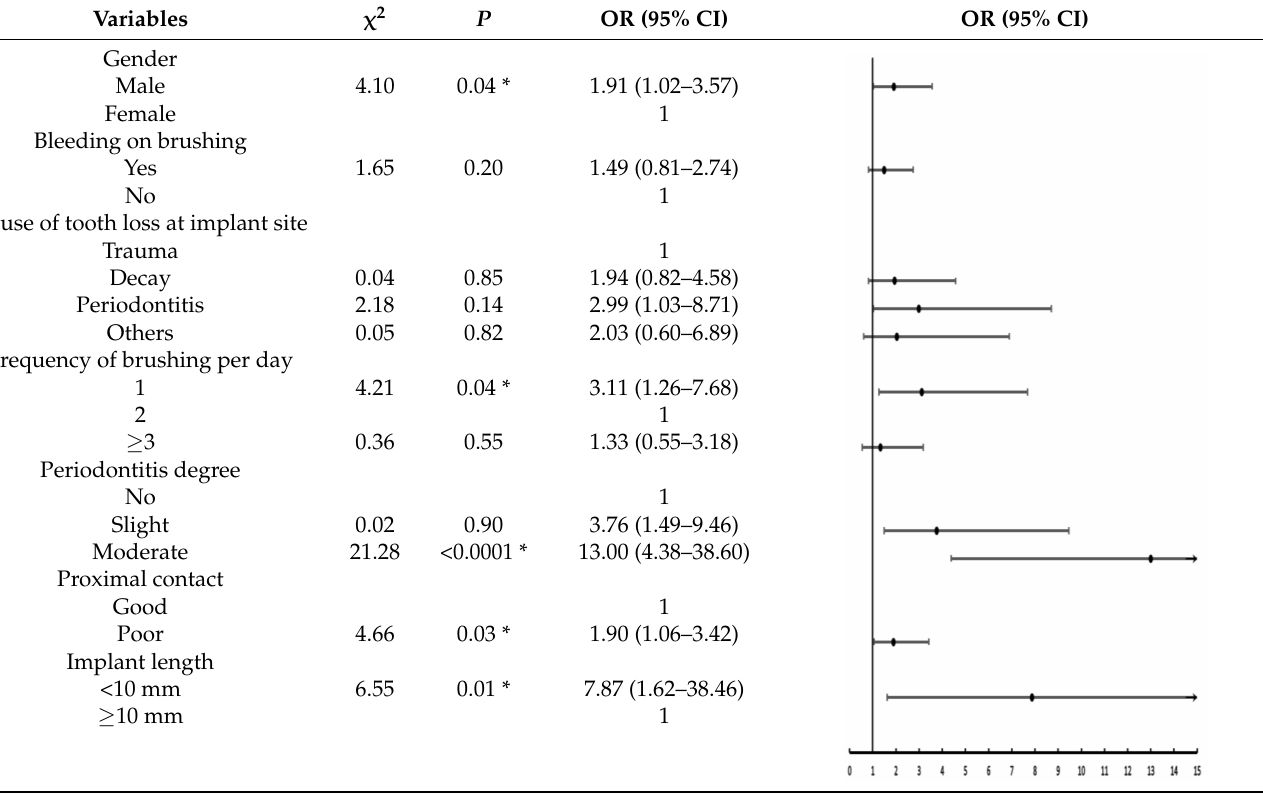
Table 3. Multiple Logistic regression analysis of 248